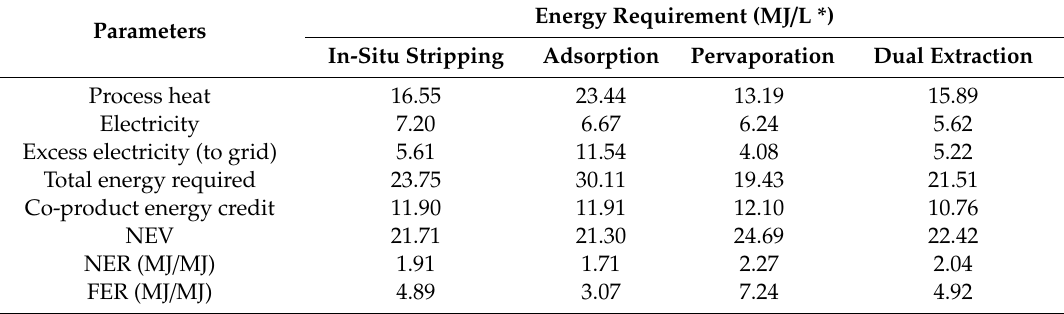
Table 5. Energy metrics of product separation technologies